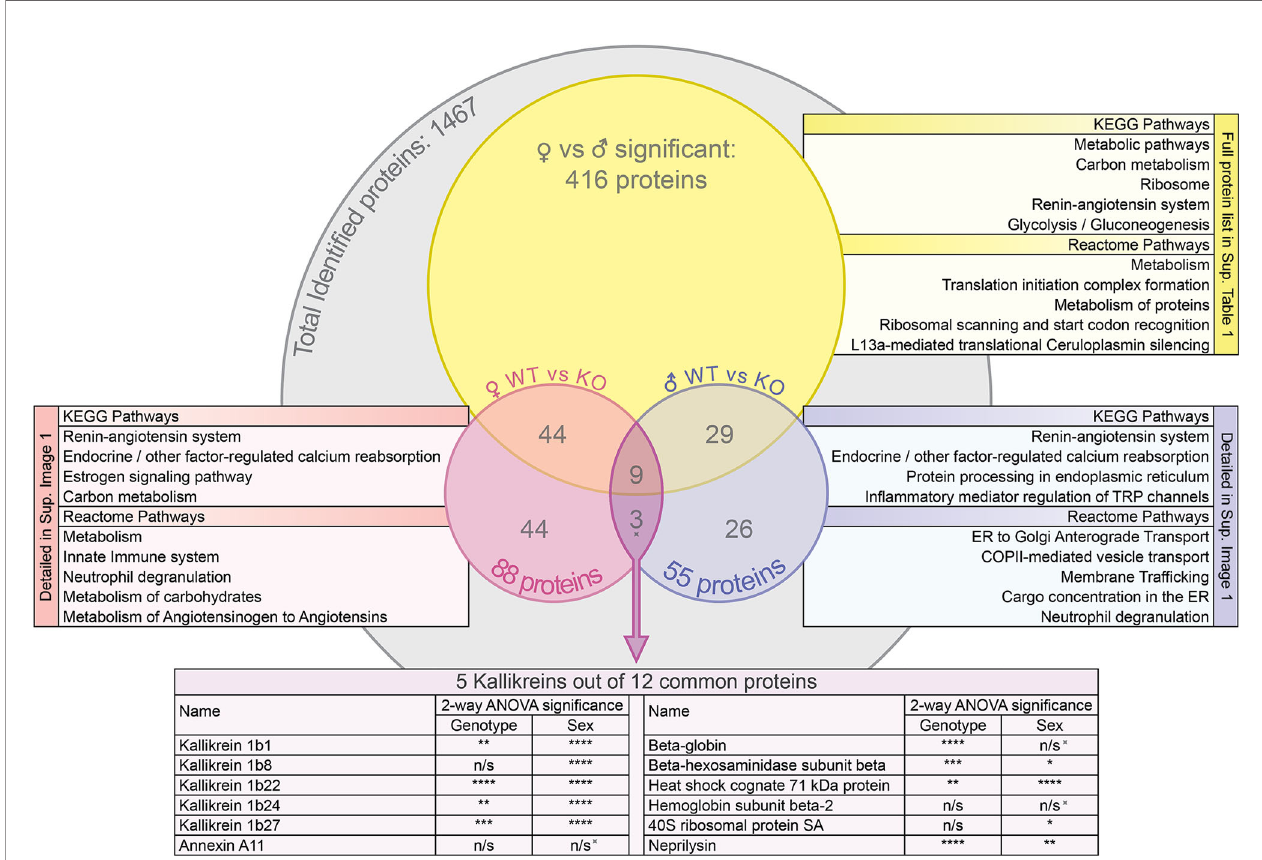
FIGURE 2 | Venn diagram of the protein groups identi fi ed by the mass spectrometry proteomic analysis and the subsequent group comparisons. For the groups of proteins that were signi fi cantly different between FWT vs MWT, FWT vs FKO and MWT vs MKO animals (t-test p<0.05), the most signi fi cant KEGG pathways and reactome pathways for network enrichment in STRING interaction network analysis are listed. Additionally, 2-way ANOVA signi fi cance results of the NSAF quanti fi cation are presented for the commonly differing proteins (as initially identi fi ed by t-test) in both male and female WT vs KO: The spiked symbol indicates the 3 out of the 12 proteins that were not signi fi cantly different between sexes. n/s for not signi fi cant (p>0.05), *p < 0.05, **p < 0.01, ***p < 0.001 and ****p <